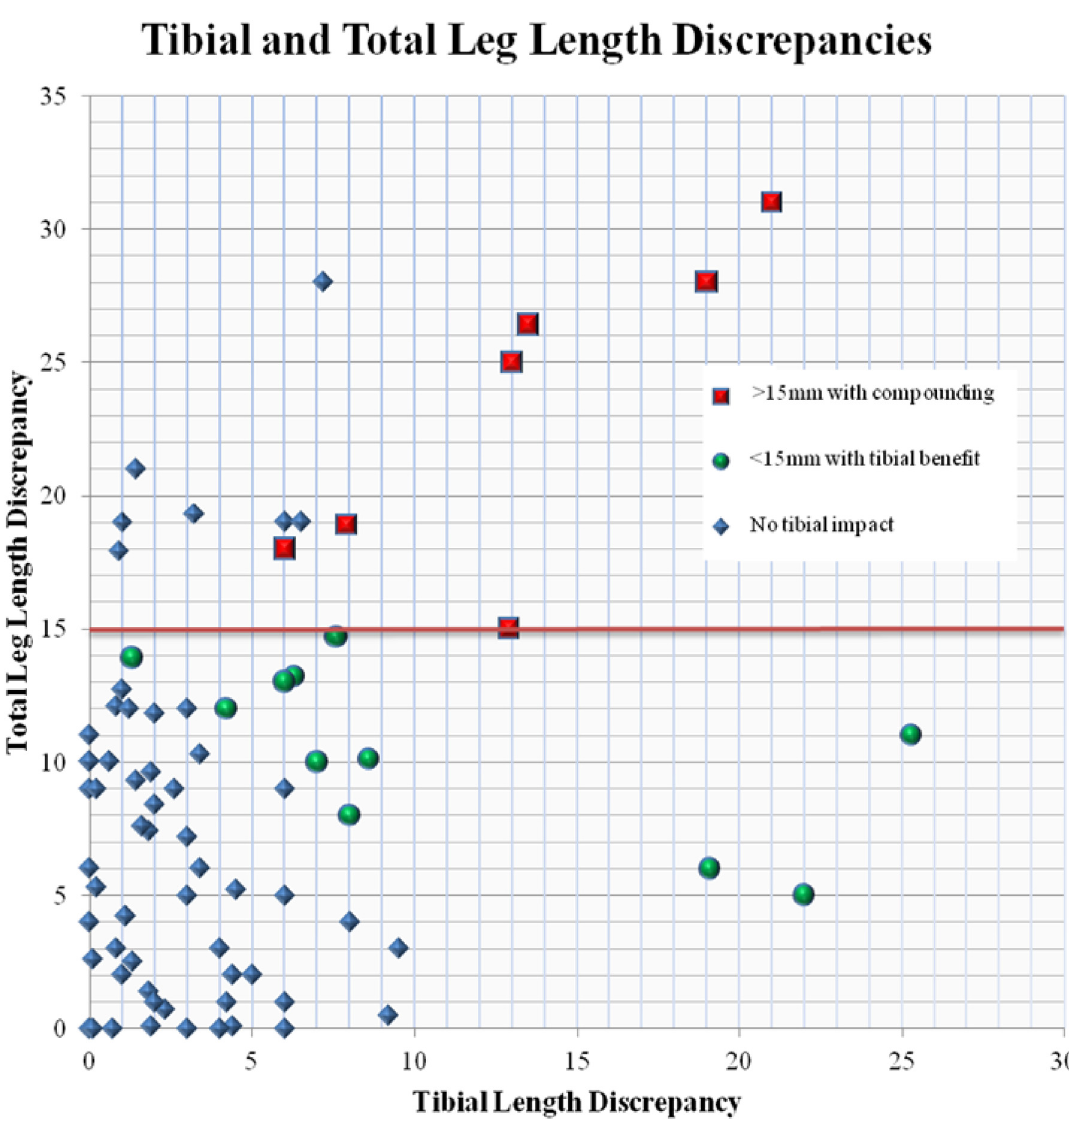
Figure 3. Leg length discrepancies compared to tibial length discrepancies. Leg disparities above the 15mm threshold that were compounded by intrinsic asymmetry of the tibias are shown in red, while those with leg length discrepancy less than 15mm only due to tibial asymmetry are in